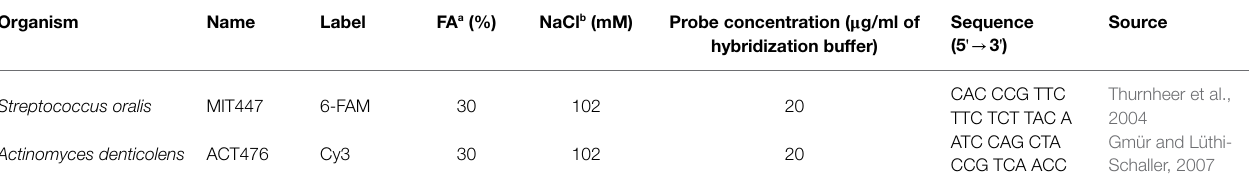
TABLE 1 | Sequence and formamide concentrations for fluorescent in situ hybridization (FISH) probes.